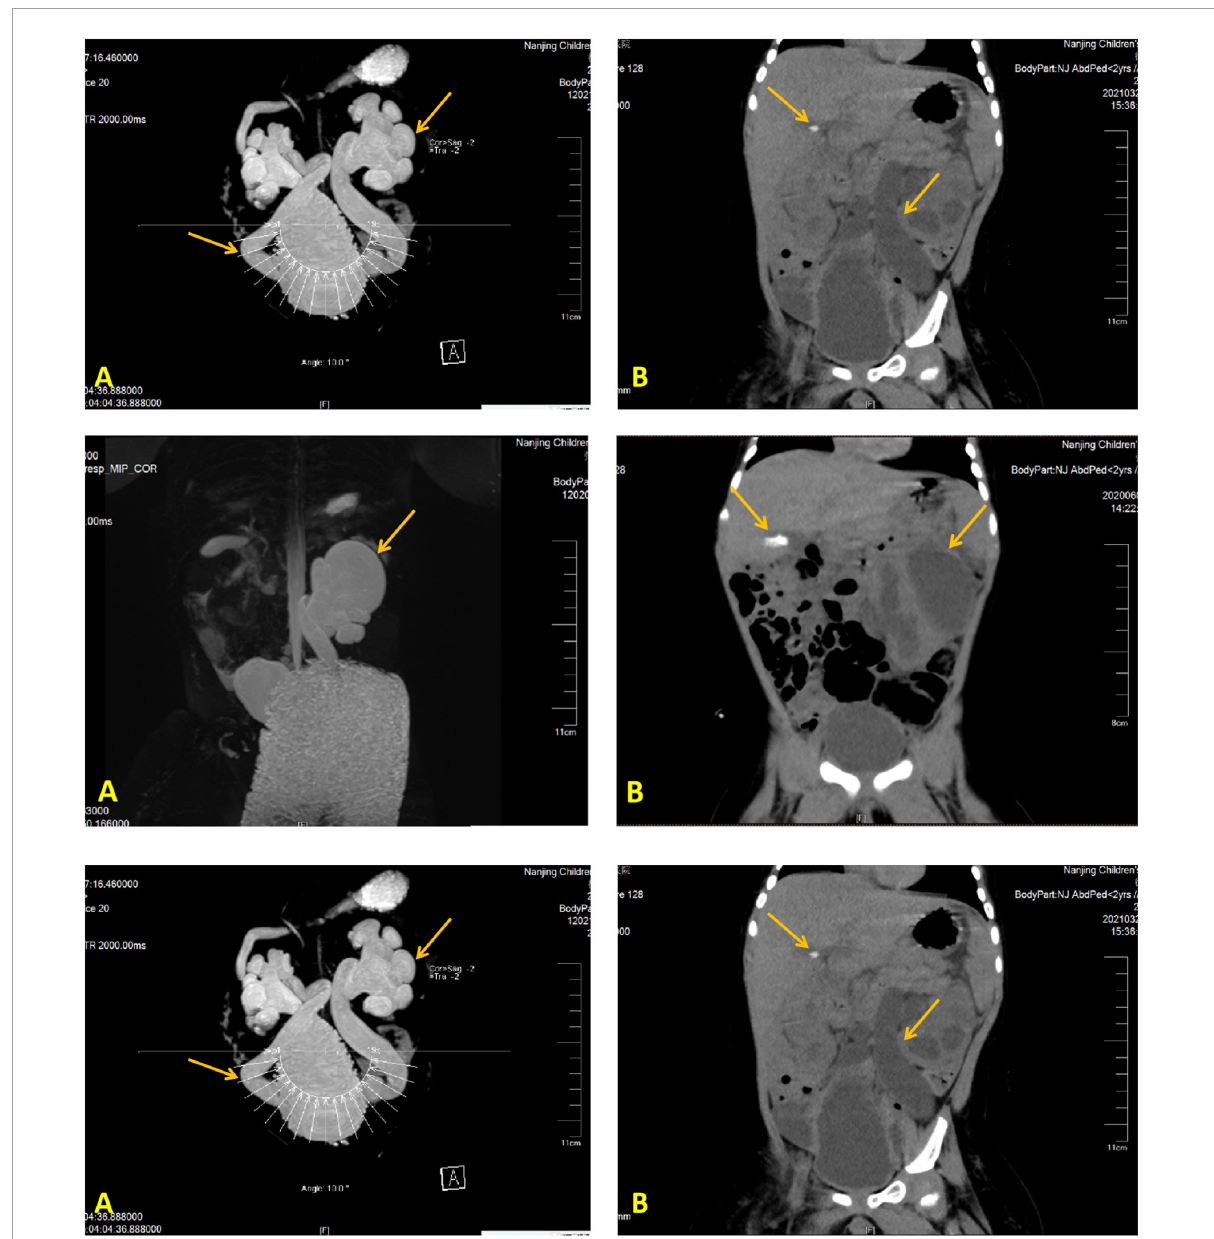
FIGURE2 Imaging modalities and results illustrating a dilated left ureter and renal pelvis and gallstone in the gallbladder. Image of the urinary MR of case 2 (A) , Full abdominal CT of case 2 (B)